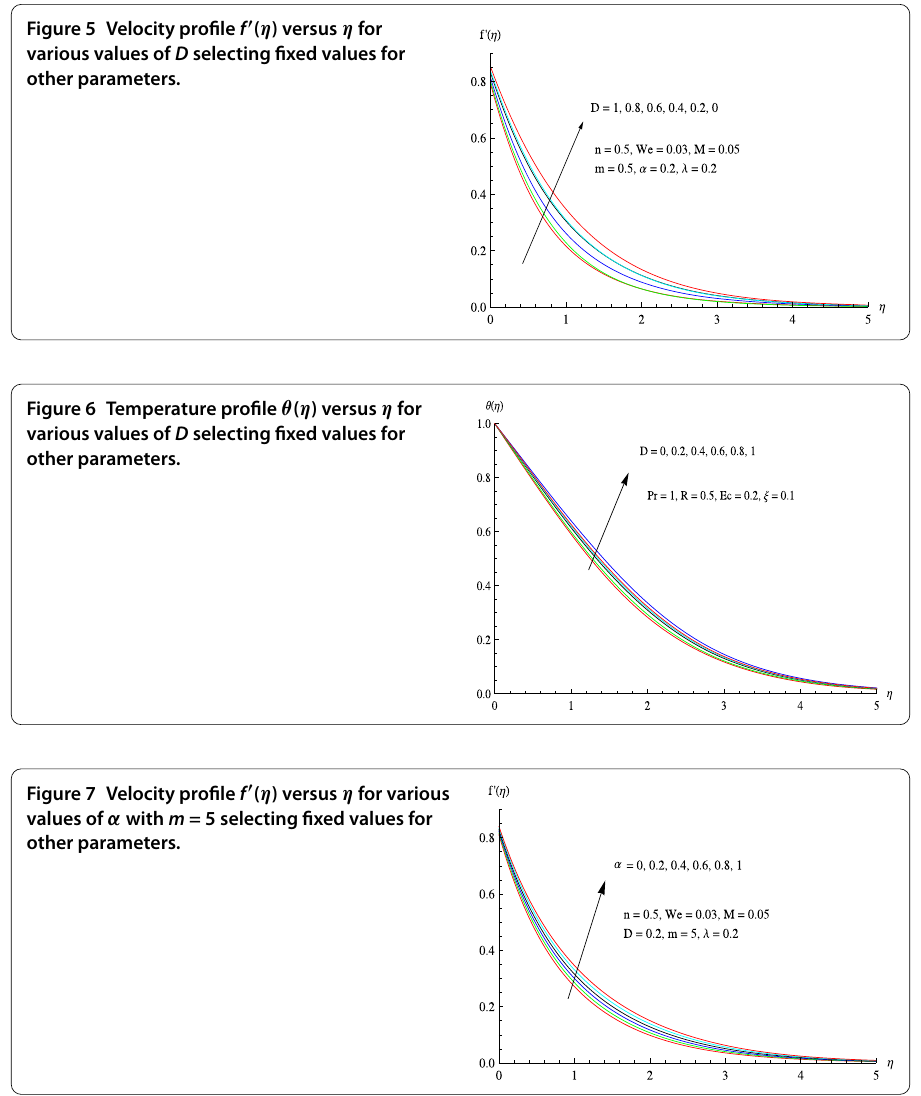
Figure 5 Velocity profile f (cid:2) ( η ) versus η for various values of D selecting fixed values for other parameters.